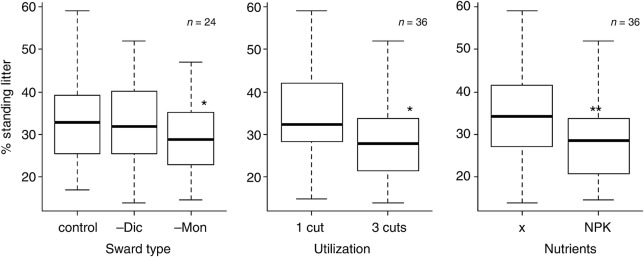
Proportion of standing litter based on total biomass found in the canopy profiles shortly before the harvest in July 2009 depending on experimental factors. The boxes show the median and first and third quartiles. For abbreviations of treatments, refer to Table 1. Asterisks denote significant differences of factor levels compared with the reference level (sward control, utilization 1/year, fertilization x) in a GLM with negative binomial error distribution (link: logit). **P < 0.01, *P < 0.05.